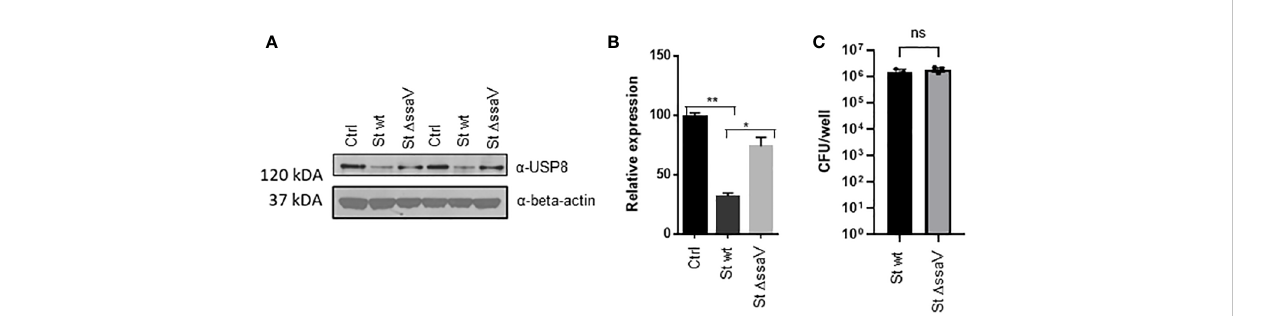
FIGURE 2 S. Typhimurium downregulates USP8 expression in macrophages and depends on the SPI-2 expression. (A, B) . THP-1 cells were infected with S. Typhimurium wild type or D ssaV lacking SPI-2 for 24 hours. Each sample was lysed, followed by western blotting to detect USP8 or loading control ( b -actin; A ). The abundance of USP8 was normalized to the b -actin as measured by ImageJ. The results of USP8 abundance are shown in a graphical form, where the statistical signi fi cance was determined by 1-way ANOVA (B) . The number of independent replicates for this experiment was 2 (n=2). (C) . Intracellular bacteria in THP-1 macrophages infected for 24 hours with S. Typhimurium wt compared to D ssaV mutant. The intracellular counts were obtained by using a gentamicin protection assay. The number of independent replicates for this experiment was 3 (n=3). P-values were indicated as follows: * p ≤ 0.05; ** p ≤ 0.01; ns, not signi fi